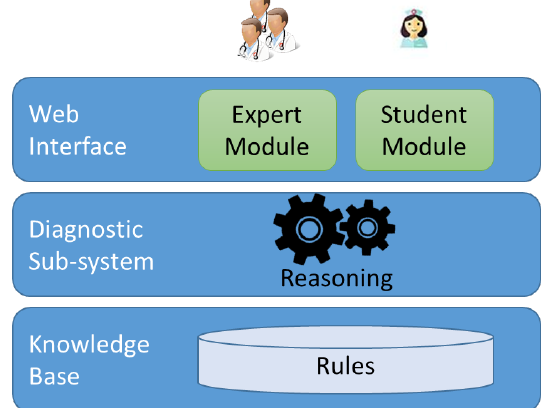
Figure 1. MediExpert